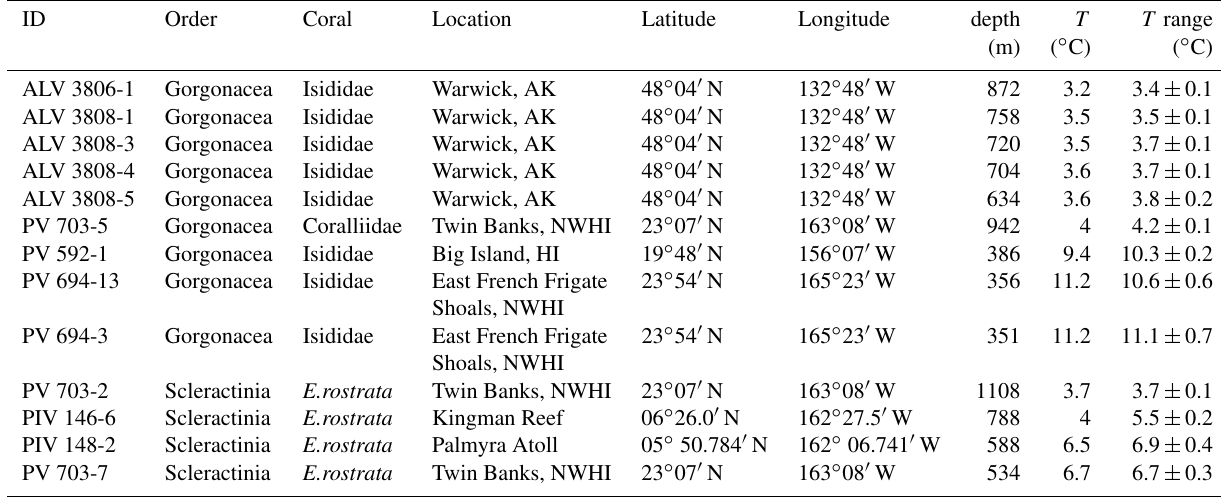
Table 1. Thirteen scleractinian and gorgonian deep-sea corals were collected live by submersible diving, with depth and temperature mea- sured at the time of collection. Temperature ranges are mean with standard deviation and come from Hawaii Ocean Time Series (Karl and Lukas, 1996) and cruises extracted from the National Ocean Database (Boyer et al., 2013). NWHI: Northwest Hawaiian Islands. ID Coral